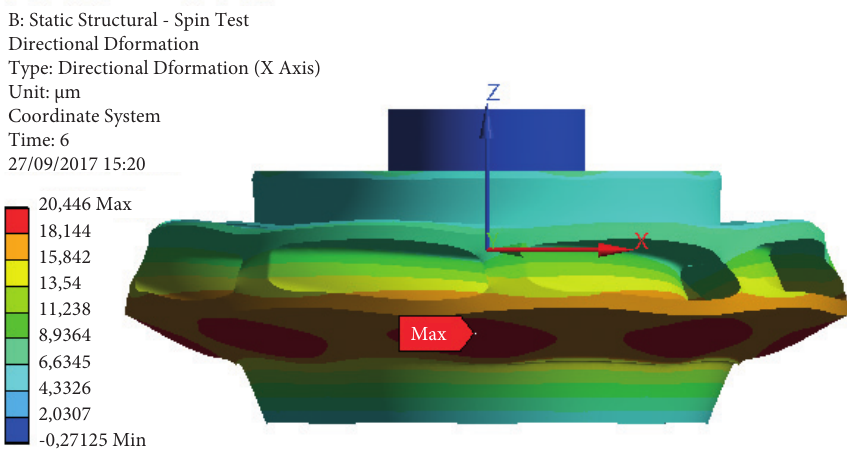
Figure 9. Impeller radial deformation induced by spin test operation